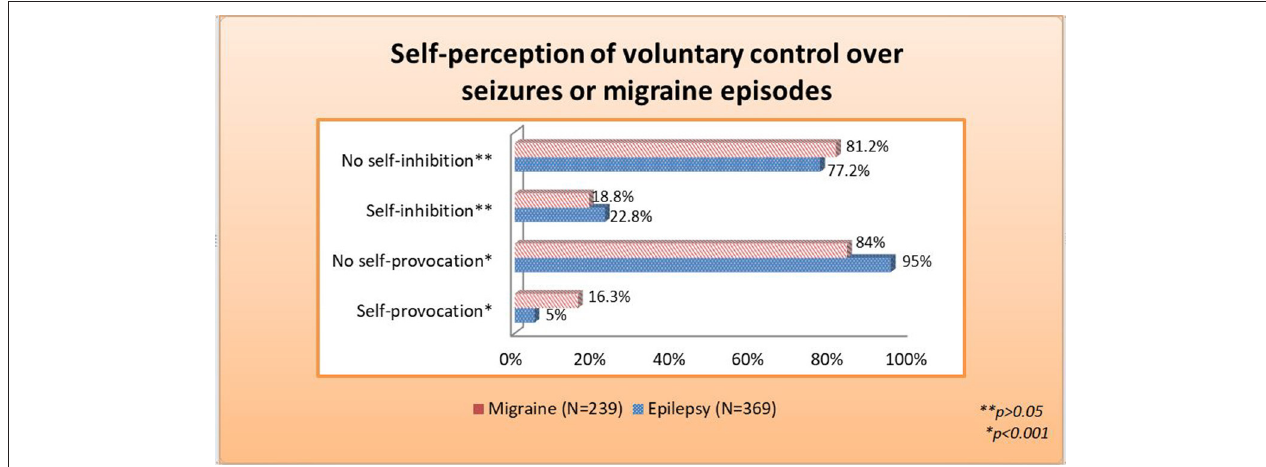
FIGURE 2 | Self-perception of voluntary control over seizures or migraine episodes.